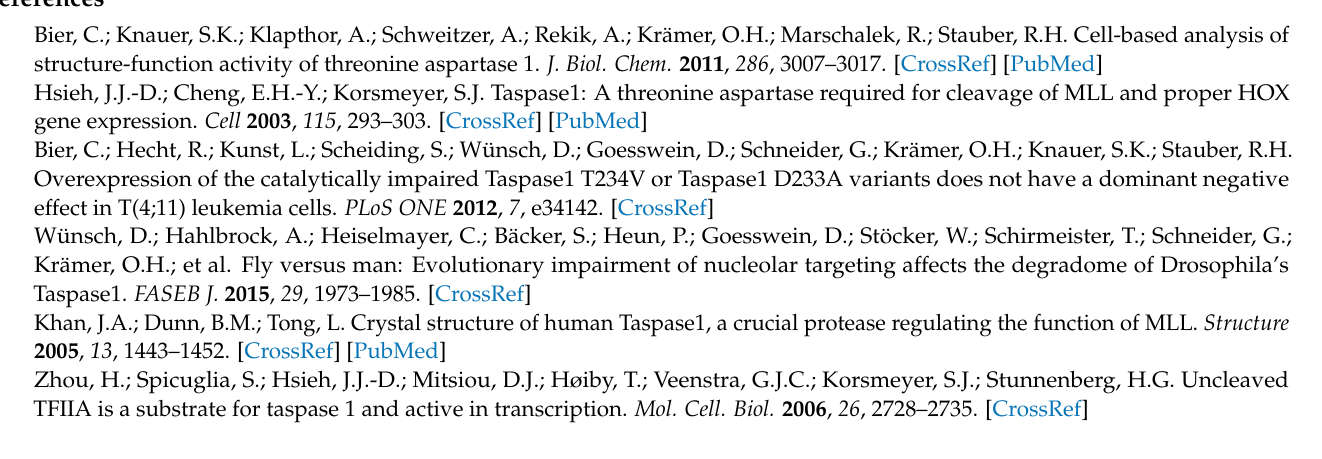
Figure S2: Densitometric quantification of E2 induction; Figure S3: Taspase1 and Topo II co-localize in HeLa cells; Figure S4: Schematic workflow of the PLA procedure and the image analysis pipeline; Table S1: Proteins identified in Taspase1-GFP complexes by mass